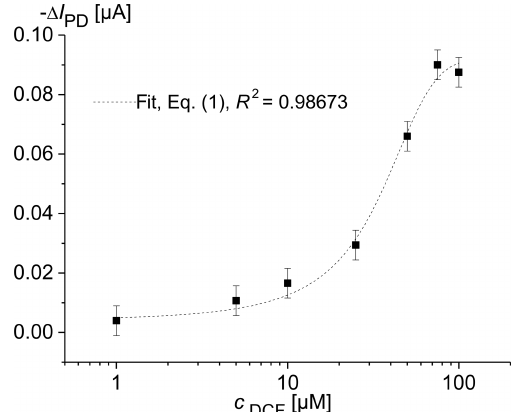
Figure 2. Change in the photodiode current I PD in dependence on the concentration of diclofenac (DCF) for living S. cerevisiae BY4741 p426PDR5-tGFP cells, immobilized in 0.75% agarose gel in the lower microfluidic chambers (7 × 10 6 cellsmL − 1 ). The up- per microfluidic chamber of the measuring channel was overflowed with MM, containing DCF, at a rate of 20µLmin − 1 . MM without DCF was pumped through the reference